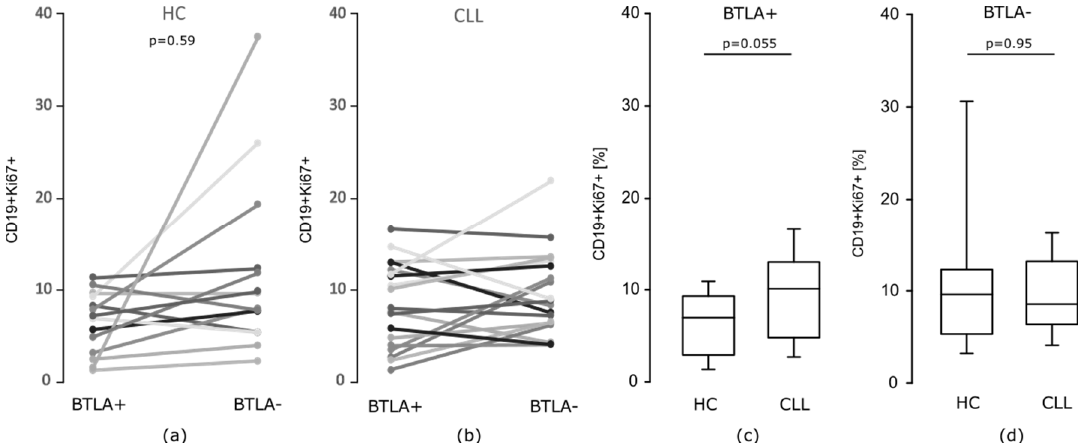
Figure 6. The proportion of BTLA positive and negative cells expressing Ki67 in B cell compartment. ( a , b ) The proportion of BTLA positive and negative cells expressing Ki67 in B cell compartment in particular individuals: ( a ) in healthy controls (HC) ( n = 14), a lower Ki67 expression in BTLA positive B cells was observed ( p = 0.059, test Wilcoxon), ( b ) while in CLL patients (n = 19), there were no statistically significant differences; ( c , d ) median proportion of Ki67-expressing cells in HC ( n = 14) and CLL patients ( n = 19) in BTLA positive ( c ), and BTLA negative B cells ( d ). The central line shows the median, whiskers represent from the first quartile to the third quartile.